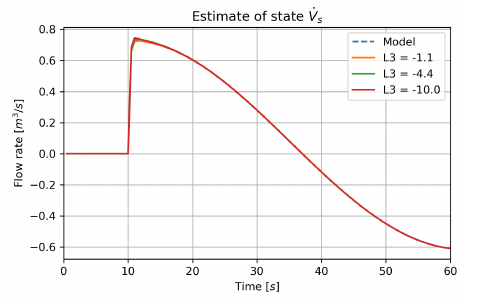
Figure 8: Effect of measurement noise on the state es- timates with varying gain.